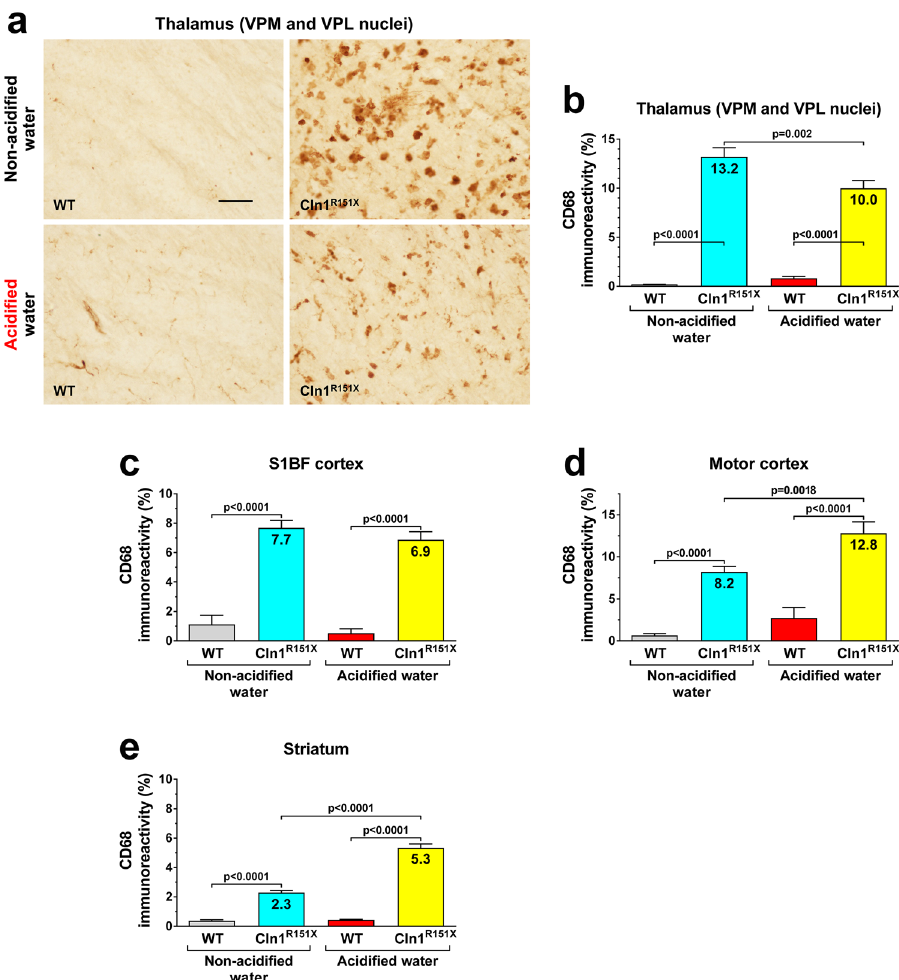
Figure 4. Acidified drinking water in Cln1 R151X mice attenuates microglial activation in the thalamus and augments it in the motor cortex and striatum. A group of Cln1 R151X and wild-type (WT) male mice received